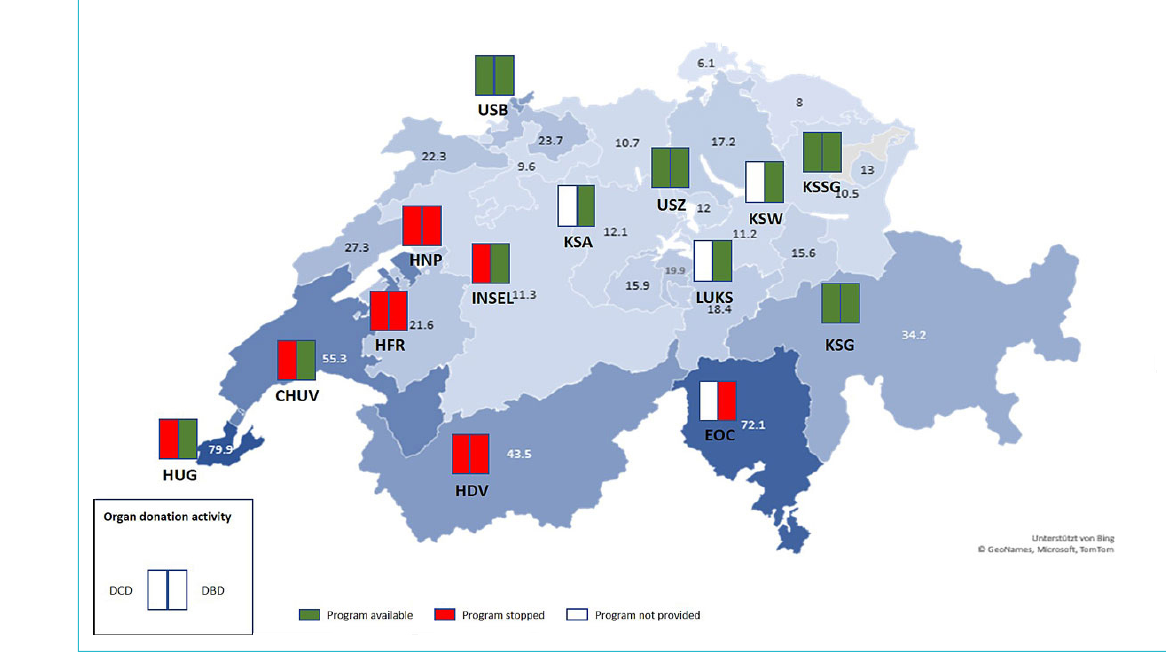
Figure 1: Availability of DCD programmes (left column) and DBD programmes (right column) in the 14 procurement centres in Switzerland on 16 April 2020, according to the stepwise shutdown approach for organ procurement described in “Patients and methods” (table 1). The preva- lence of COVID-19 for each Swiss canton is shown per 10,000 inhabitants on 6 April 2020 (www.corona-data.ch). In all active procurement programmes, a centralised national case-by-case triage was applied between 17 March and 11 May 2020 (step 1, not shown).CHUV = Univer- sity Hospital Lausanne; DBD = donation after brain death; DCD = donation after circulatory death; EOC = Cantonal Hospital Lugano; HDF = Cantonal of Hospital of Valais; HFR = Cantonal Hospital Fribourg; HNP = Cantonal Hospital Neuchatel; HUG = University Hospital Geneva; In- sel = University Hospital Berne; KSA = Cantonal Hospital Aarau; KSG = Cantonal Hospital of Graubünden; KSW = Cantonal Hospital Win- terthur; KSSG = Cantonal Hospital St Gallen; LUKS = Cantonal of Hospital of Lucerne; USB = University Hospital Basel; USZ = University Hospital